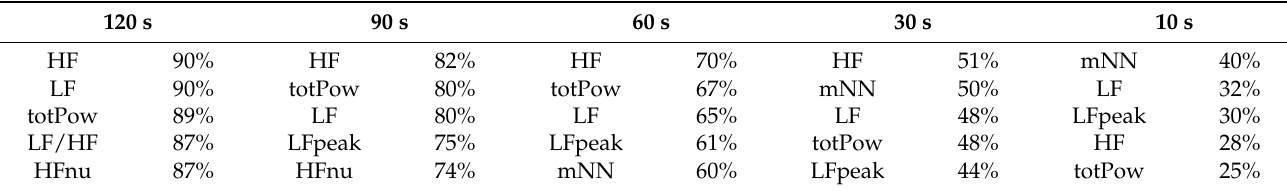
Table 2. Top 5 features by time frame regarding the correlation